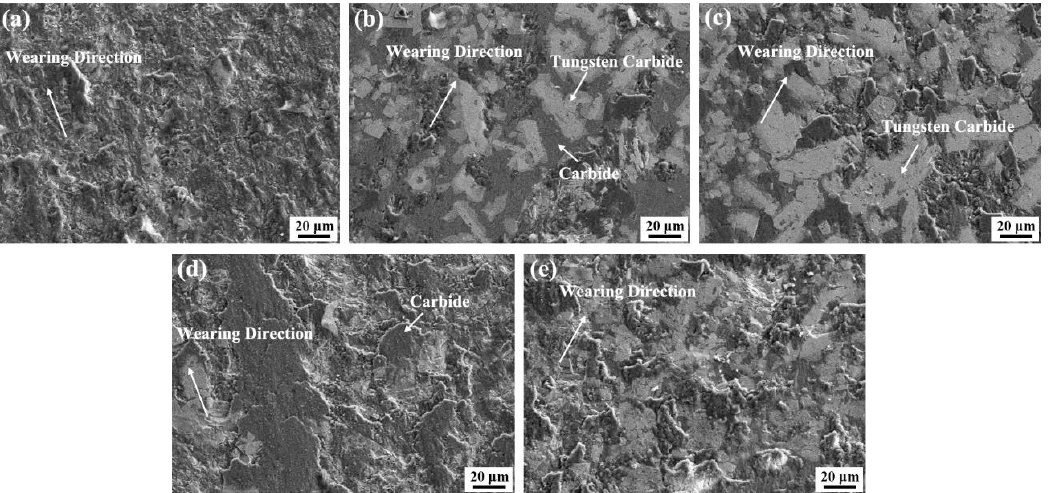
Figure 8. Morphologies of Ni-based tungsten carbide cladding layer after wear under different CeO 2 contents: ( a ) 0 wt.%CeO 2 , ( b ) 0.1 wt.% CeO 2 , ( c ) 0.2 wt.% CeO 2 , ( d ) 0.5 wt.% CeO 2 , and ( e ) 1.0 wt.% CeO 2